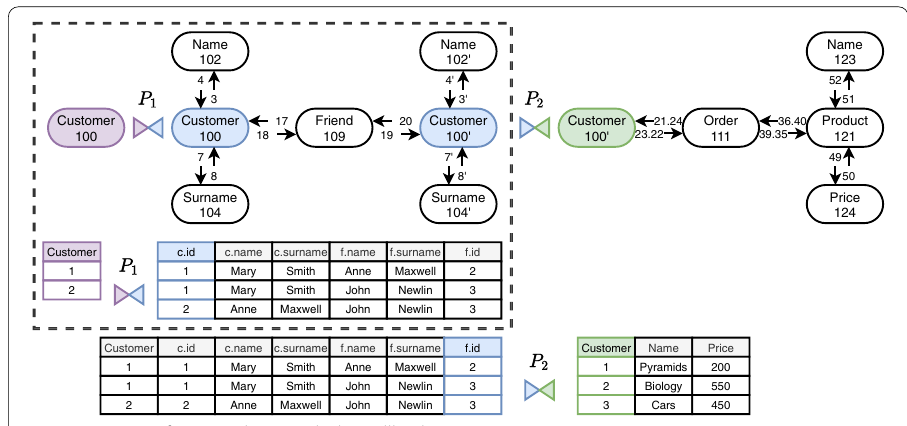
Fig. 17 Joining of intermediate results by